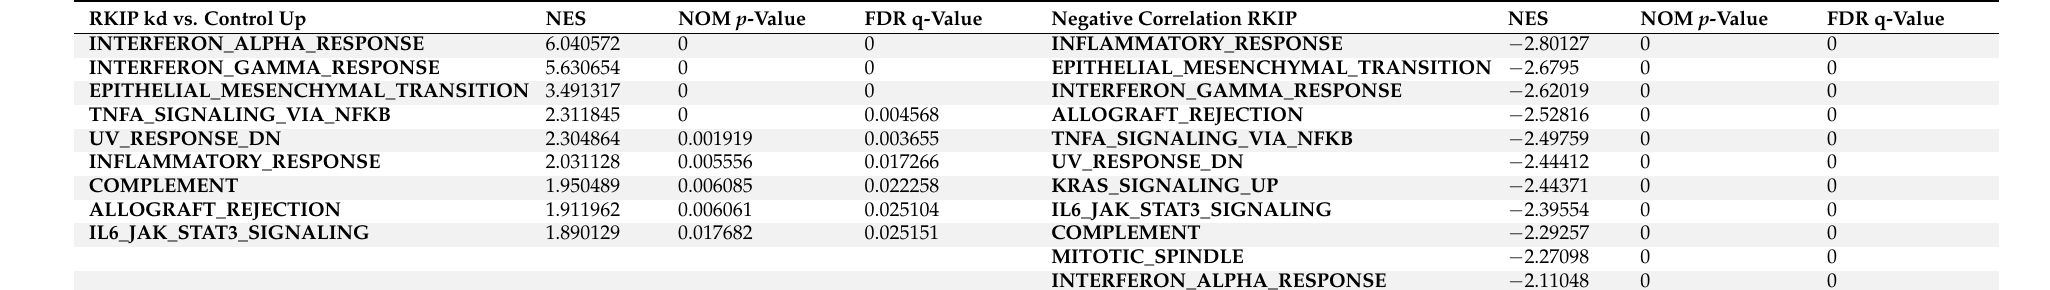
Table 1. GSEA kd up and negative correlation. The top hits are listed from the GSEA analysis of the RKIP knockdown (genes upregulated) and show those that are negatively correlated with RKIP expression in the breast cancer TCGA samples. All nine gene sets with q values less than 0.05 are listed. The top 11 ranked by NES of the sets negatively correlated with RKIP expression are listed. The gene signatures shared between the two groups are highlighted. NES, Normalized Enrichment Score.